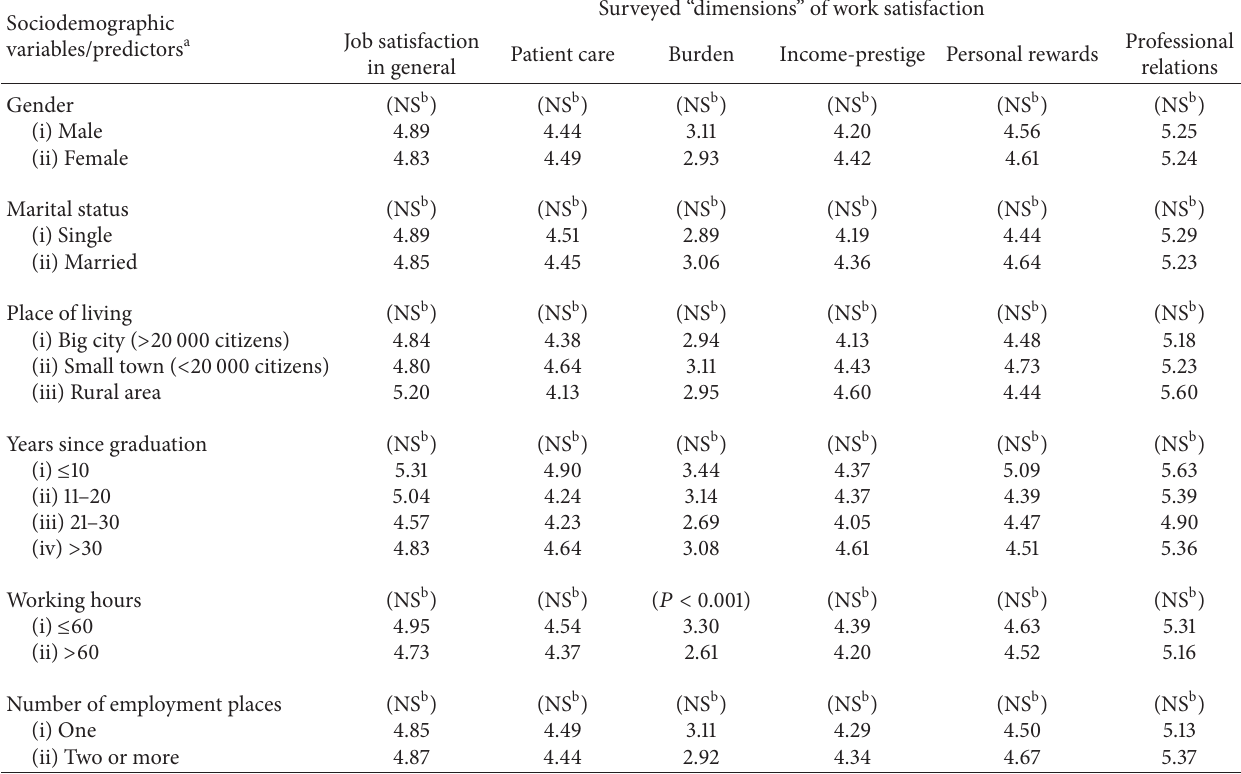
Table 3: Sociodemographic discrete predictors (along with corresponding 𝑃 values) of each scoring referring to job satisfaction in general, patient care, burden, income-prestige, personal rewards, and professional relations among surveyed